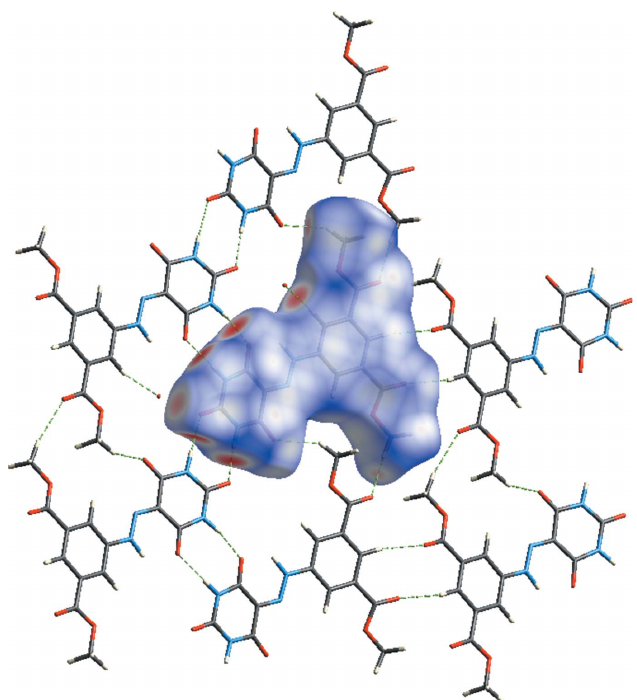
Figure 5 A view of the Hirshfeld surface mapped over d norm , with interactions to neighbouring molecules shown as green dashed lines.